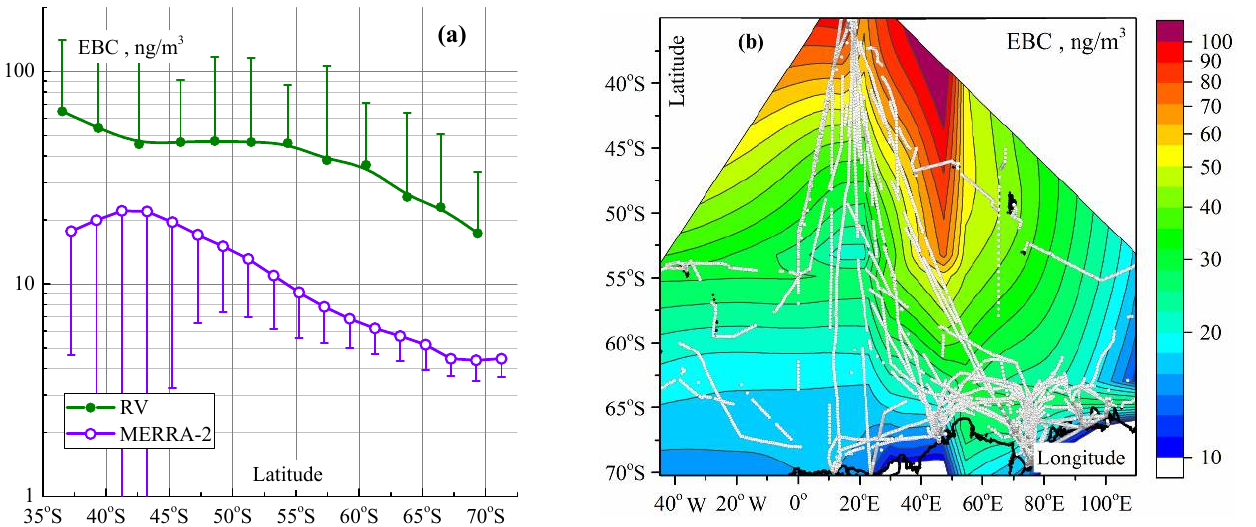
Figure 4. Average spatial distribution of EBC concentrations: ( a ) latitude behavior using ship-based (RV) measurements and MERRA-2 reanalysis data, and ( b ) latitude–longitude distribution based on the interpolation of ship-based data.